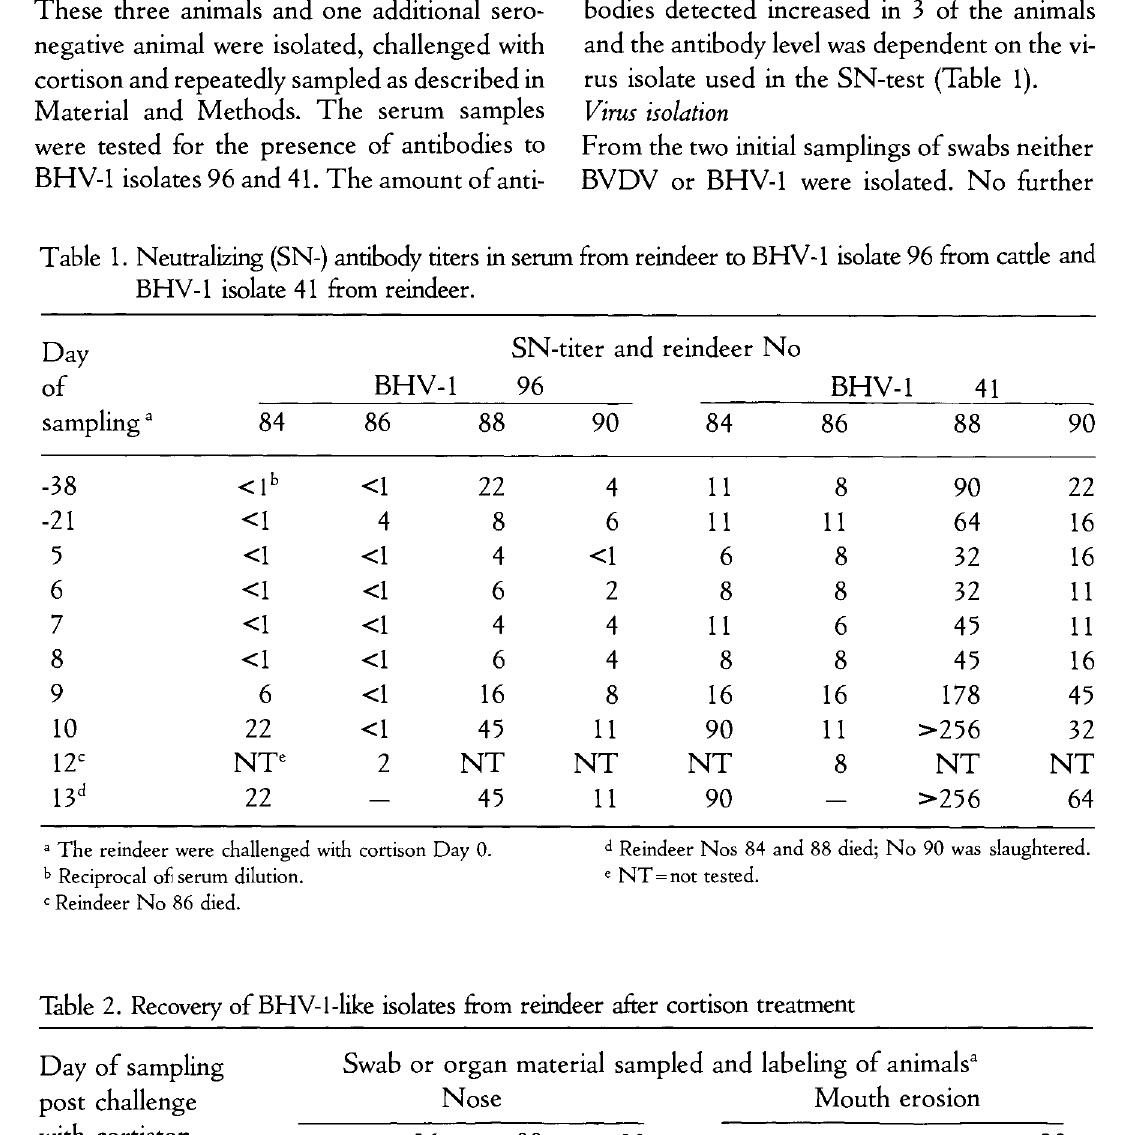
Table 2. Recovery of BHV-l-like isolates from reindeer after cortison treatment Day of